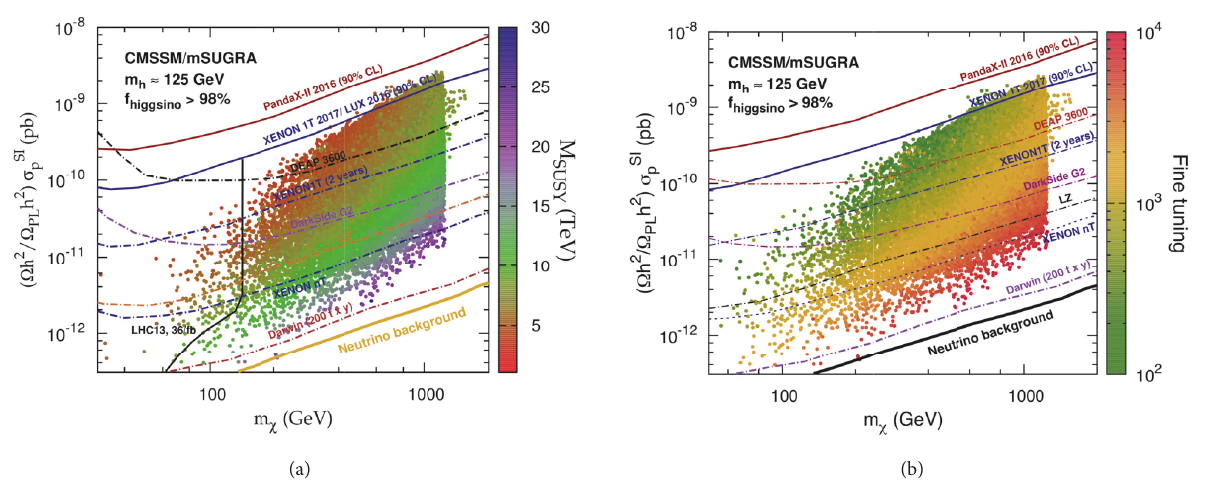
= (𝑚 𝑚 ) 1/2 in the ( 𝑚 , 𝜉𝜎 SI ̃푡 1 ̃푡 2 휒 푝 ) plane with higgsino DM under CMSSM/mSUGRA boundary conditions. (b) SUSY